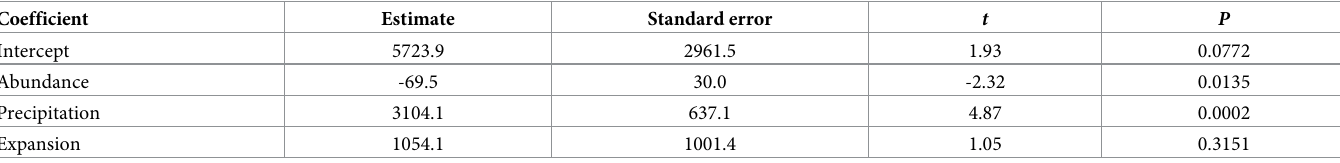
Table 1. Estimates, standard errors, and t-tests from a general linear model examining influences of elk abundance, October–December precipitation (natural log transformed), and expansion on forage biomass (kg) in the Davison meadow complex. Expansion was a categorical variable for years before (2005–2015, coded 0) and after (2016–2019, coded 1) the Davison herd expanded its home range. Forage biomass was the sum of biomass in the seven sectors (South Davison, A, B, C, Picnic, WPC, and Horsebarn) continuously grazed by Davison and Levee herds between 2005 and 2019. The model adjusted r 2 was 0.67 and the residual standard error was 1567. One- tailed probability values are reported for abundance and precipitation as we expected abundance to be inversely, and precipitation to be positively related to forage